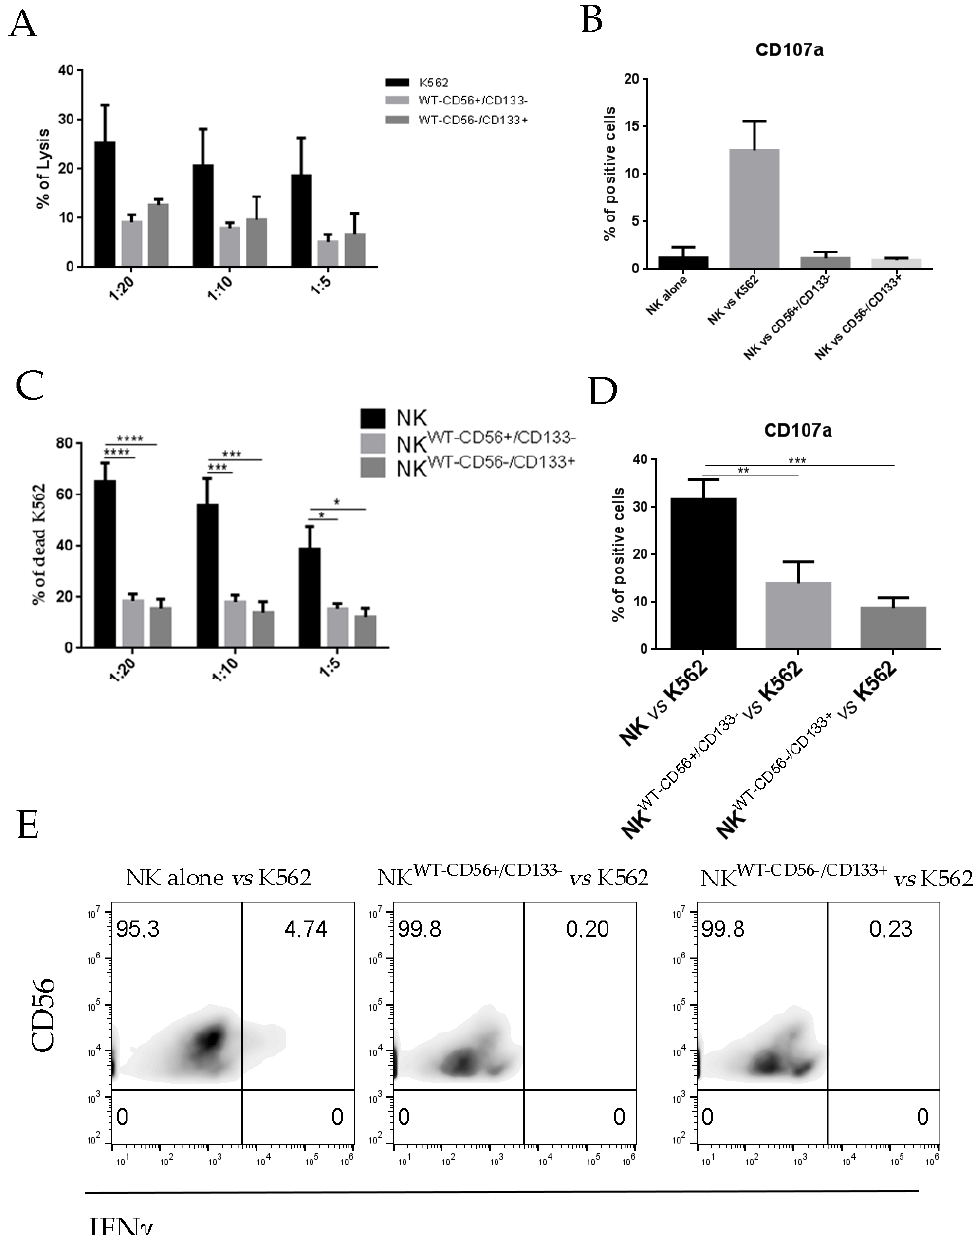
Figure 4. ( A , B ) Fresh NK cells were isolated from the peripheral blood of healthy donors and used as effector cells against different tumor cell line. K562 target cells were used as control. ( A ) Cytolytic activity of freshly isolated NK cells against different WT target cell line as indicated. Bar graphs represent the mean ± SEM ( n = 3). ( B ) Percentage ± SEM of CD107a expression by freshly isolated NK cells against different WT target cell line as indicated ( n = 4). ( C – E ) Freshly isolated NK cells were co-cultured alone or with WT tumor cell lines as indicated (WT 56 + /133 − and WT56 − /133 + ). After 48 h of conditioning, NK cells were tested as effector cells against K562 cell target. Percentage of ( C ) lyses ± SEM and ( D ) CD107a ± SEM expression using three different NK cell donors for each WT cell line. p -values were calculated using one-way ANOVA with Fisher’s LSD multiple comparisons test (* p < 0.05, ** p < 0.01, *** p < 0.001). ( E ) IFN-g production by NK cells upon co-culture with WT cell lines. One representative experiment out three was